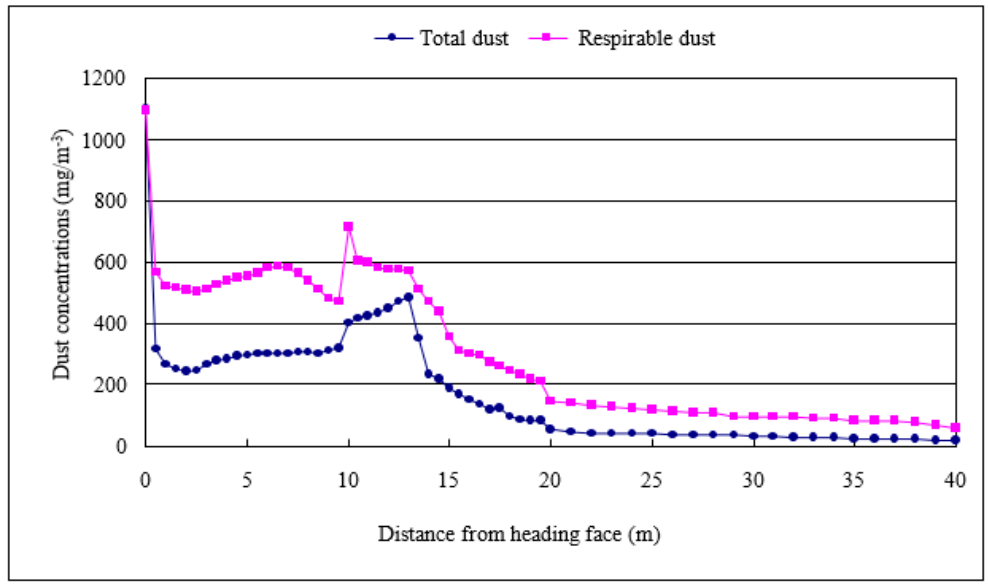
Figure 16. Face averaged dust concentration under long blowing and short suction ventilation system.